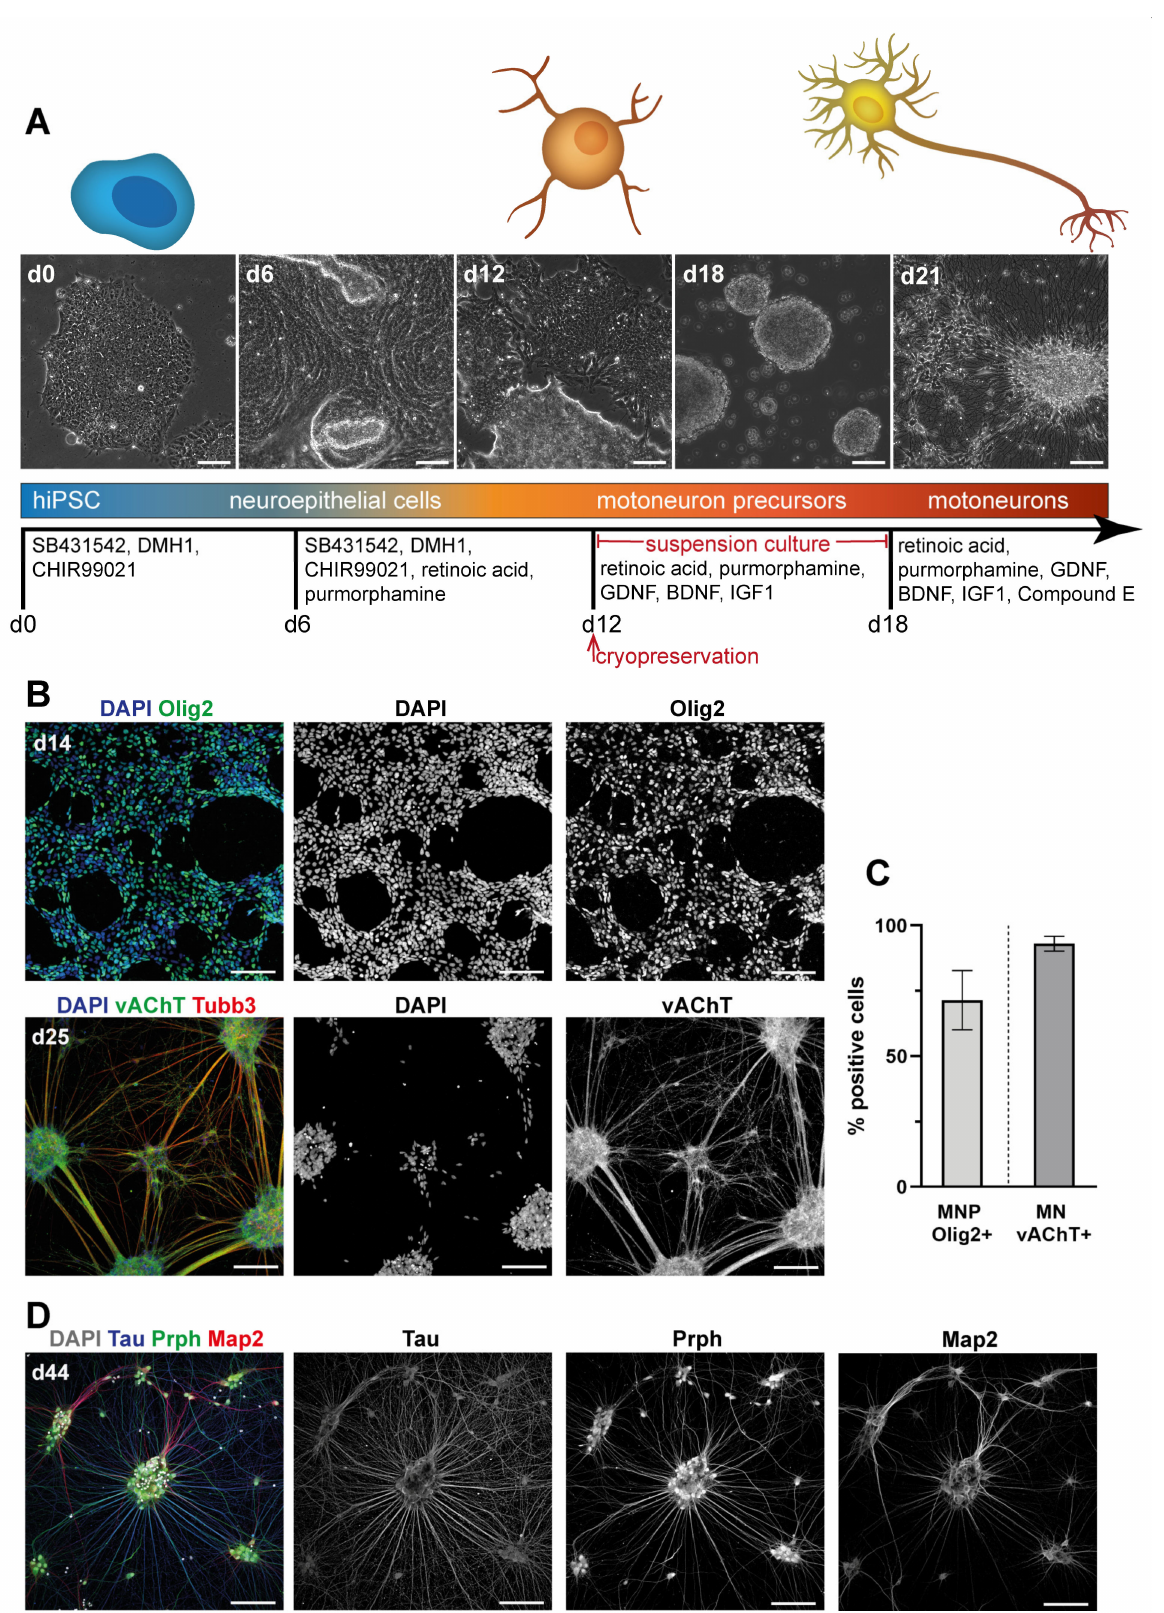
Figure 2. Morphological characteristics and marker protein expression indicate differentiation of motoneurons from hiPSC. ( A ) Schematic representation of protocol timeline and differentiation factors used. Micrographs show representative brightfield images of cell populations at differentiation times as indicated on the top left of images. MN precursors